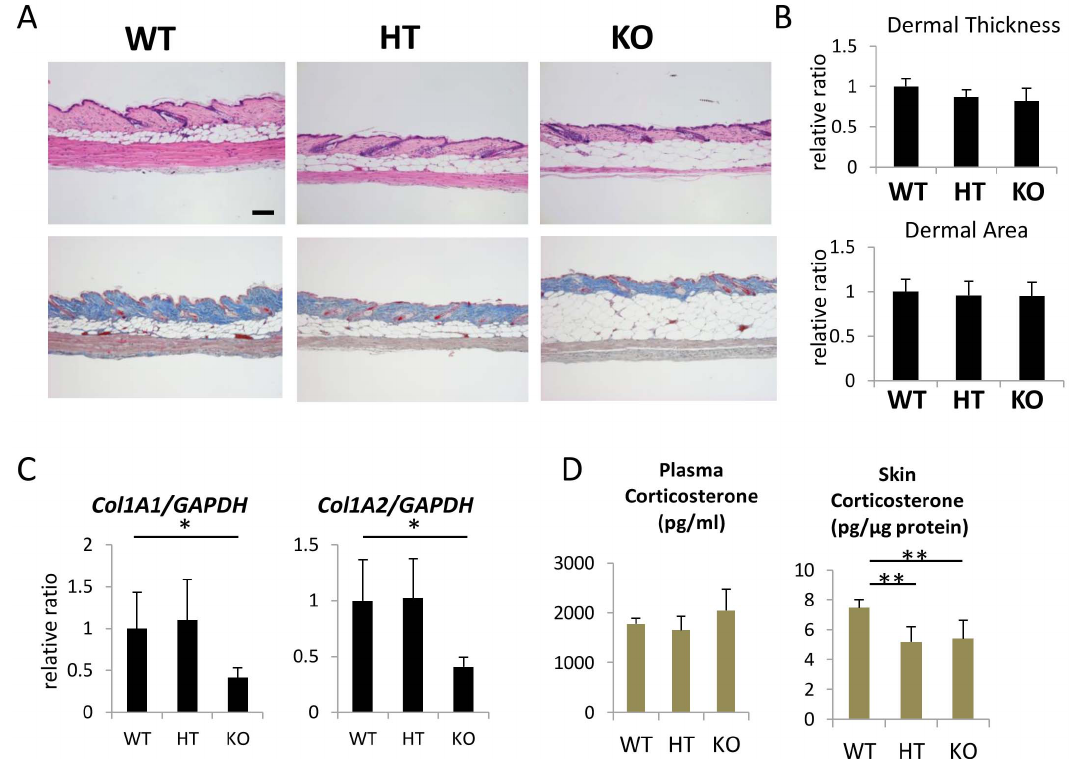
Figure 6. Dermal thickness and collagen type1 expression of 1-year-old 11 b -HSD1 knockout mouse skin. (A) H&E staining (upper panel), Masson’s trichrome staining (lower panel) of 1-year-old WT, HT, and KO mouse skin. Bar =100 m m. (B) Dermal thickness and the dermal area of 1-year-old mouse skin. Dermal thickness was calculated by averaging the thickness measured at five locations in each section. Three sections from each mouse were evaluated. The dermal area in each mouse was measured using Image J. Bars show the mean epidermal thickness 6 SD (WT: N=4, HT: N=5, KO: N=6). (C) The relative expression of Col1A1 and Col1A2 in 1-year-old WT, HT, and KO mouse skin. GAPDH was used as an internal control. Bars indicate the mean 6 SD (WT: N=4, HT: N=5, KO: N=6; *P , 0.05, Student’s t-test). (D) Plasma and skin corticosterone levels in WT, HT, and KO mice were measured with ELISA. Bars indicate the mean 6 SD (WT: N=4, HT: N=5, KO: N=6; **P , 0.01, one-way ANOVA followed by the Bonferroni-Dunn test for multiple comparisons).